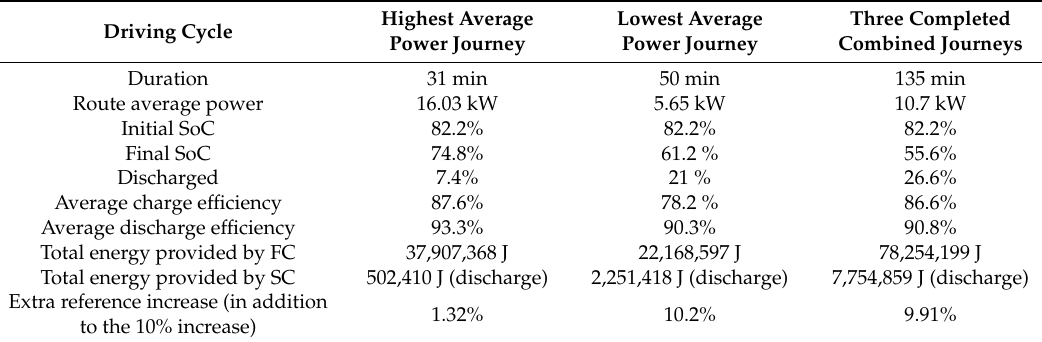
Figure 12. Relationship between load power and buck/boost converter efficiency. Table 3. Parameter summary of different bus journey